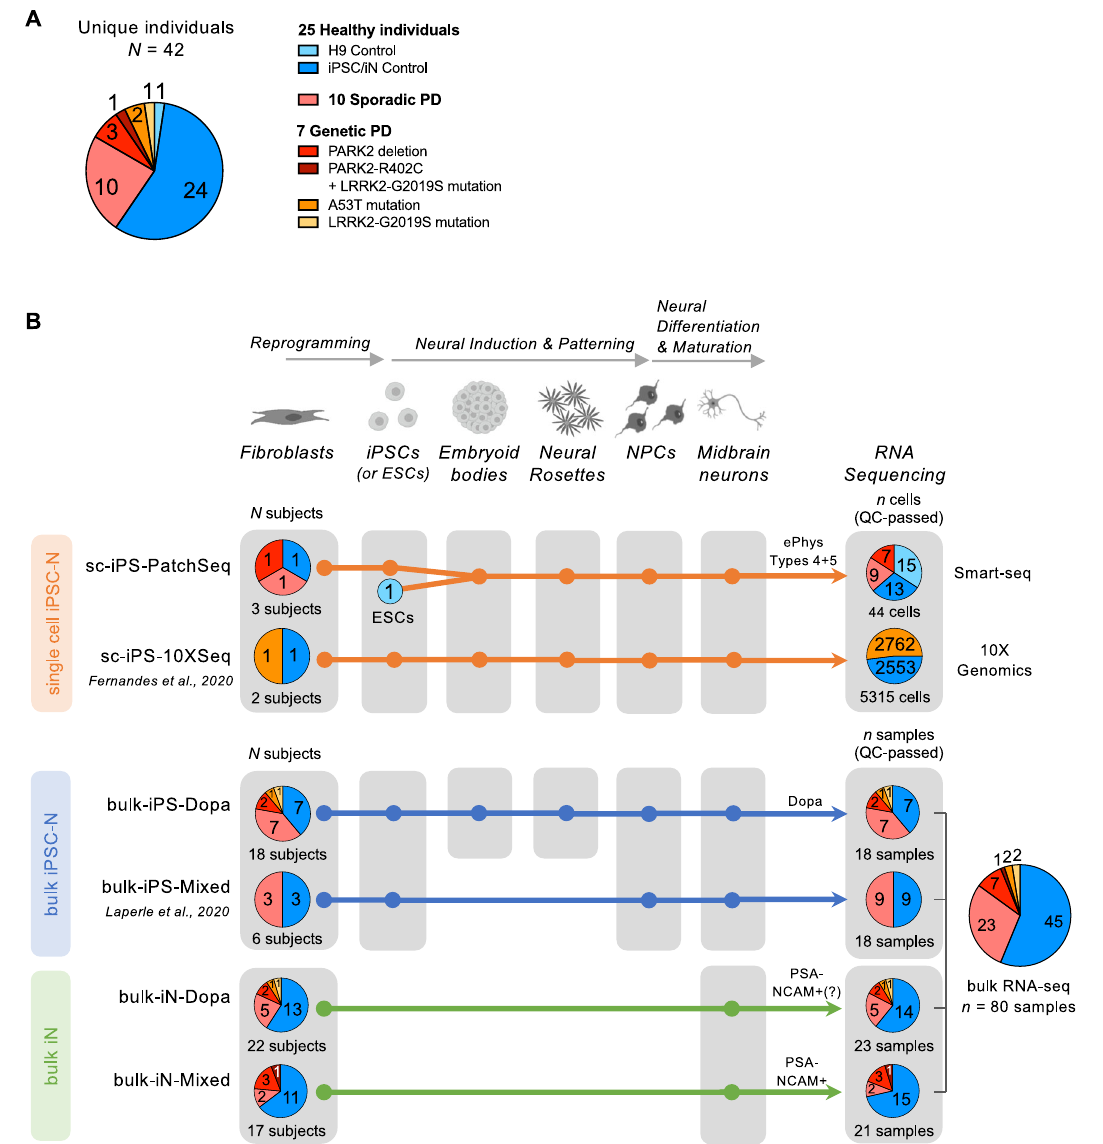
Fig. 1 Patient and sample distributions of six transcriptomic datasets of Parkinson ’ s disease reprogrammed neurons. A The transcriptome data analyzed in the present study were collected across six different datasets and originate from the reprogrammed neurons of n = 25 healthy individuals, n = 7 patients with known mutations in PD genes, and n = 10 patients with a sporadic form of the disease ( n = 42 unique subjects total). B Overview of tissue culture trajectories used in six reprogramming studies to generate in vitro midbrain-like neurons from PD patient- and healthy subject-derived fi broblasts (see Methods for details). Pie charts on the left summarize the number of subjects from which neurons were derived, color-coded by disease phenotype and mutation type as shown in ( A ). Neuron cultures were generated via induced pluripotent stem cell (iPSC) technology ( n = 4 studies) or by direct conversion of fi broblasts into induced neurons (iNs, n = 2 studies), and neuronal transcriptome data was obtained by single-cell or bulk RNA-seq ( n = 2 and 4 studies, respectively). The trajectory color re fl ects the combinatory choice of the reprogramming and sequenced method used ( orange : single-cell iPSC neuron datasets; blue : bulk iPSC neuron datasets; green : bulk iN datasets). Single-cell RNA-seq was performed on (i) functionally mature (AP Types 4 + 5) single neurons collected after patch-clamp recording (PatchSeq, n = 44) or on (ii) wild-type and isogenic SNCA-A53T neurons harvested using 10X Chromium technology 38 . The two iN datasets enriched for successfully reprogrammed (i.e., PSA-NCAM-positive) neurons using fl uorescence-activated cell sorting (FACS). The bulk-iPS-Dopa and bulk-iN-Dopa studies used an optimized differentiation protocol to generate a high proportion of midbrain dopaminergic neurons. Pie charts on the right indicate the number of cells or samples sequenced per disease state and/or mutation type. A total of 5,359 single neurons and 80 neuronal bulk samples were